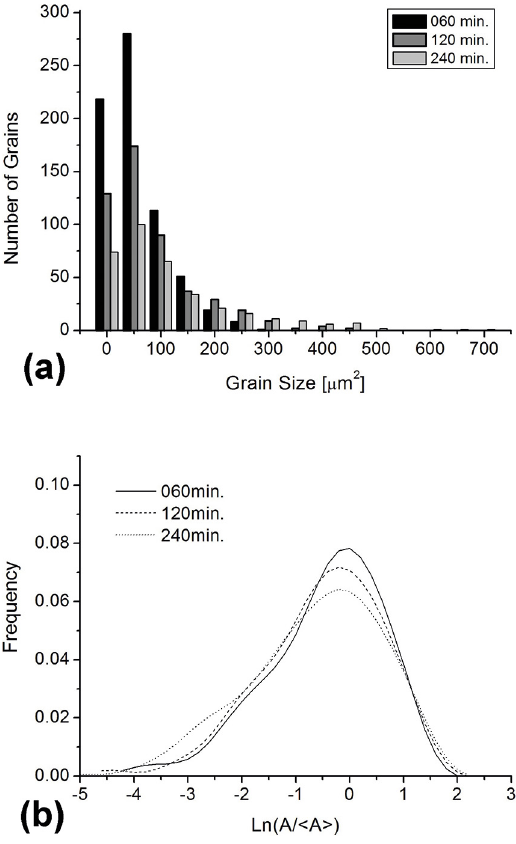
Figure 8: (a) Distribution of average grain size after 60, 120 and 240 minutes at a temperature of 948 K. (b) Normalized distribution.